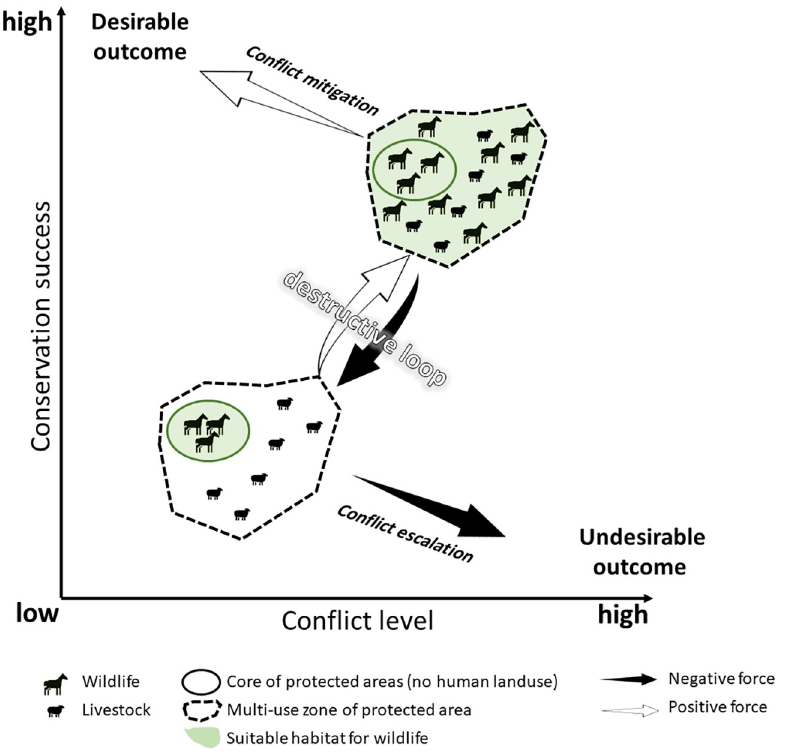
Fig 1. Possible outcomes of conservation activities for endangered species in multi-use